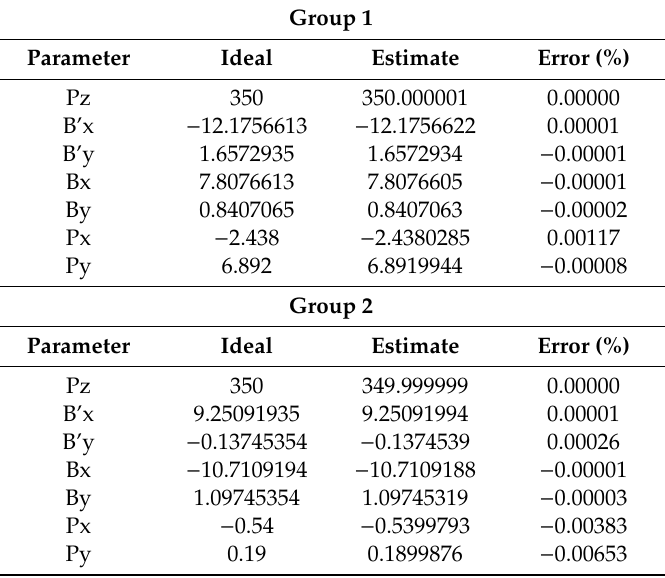
Table 2. Calibration results of the parameters obtained from Step